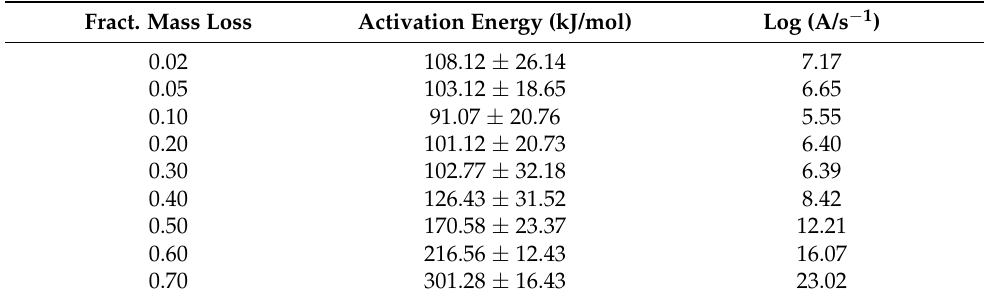
Table A1. Pre-exponential coefficient and activation energy as a function of the degree of conversion by the Friedman method for Miscanthus.